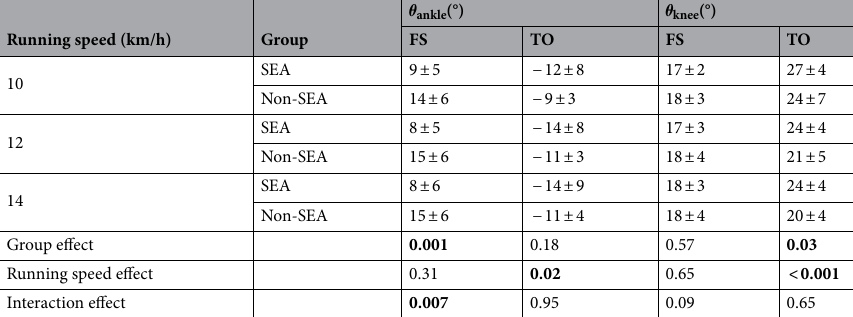
Running speed (km/h) Group FSA (°)